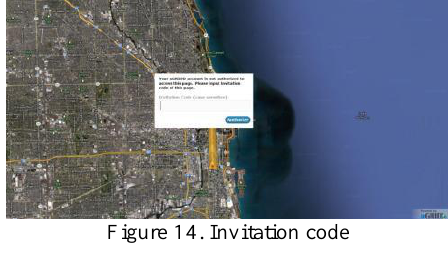
Figure 14. Invitation